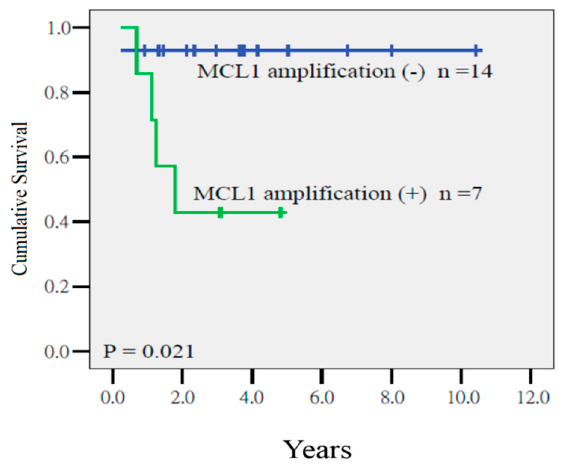
Figure 3. Distant metastasis-free survival in patients who had tumors with or without MCL1 amplification ( p = 0.021).